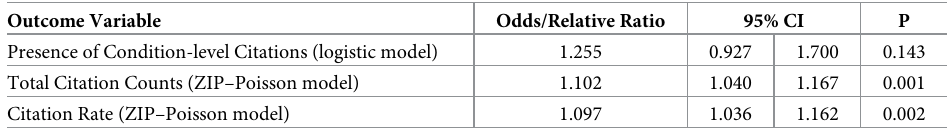
Table 3. Estimated odds ratio/relative ratio of Core Survey use, compared with the Basic Survey, in the matched sample. The estimates are adjusted for baseline facility and survey